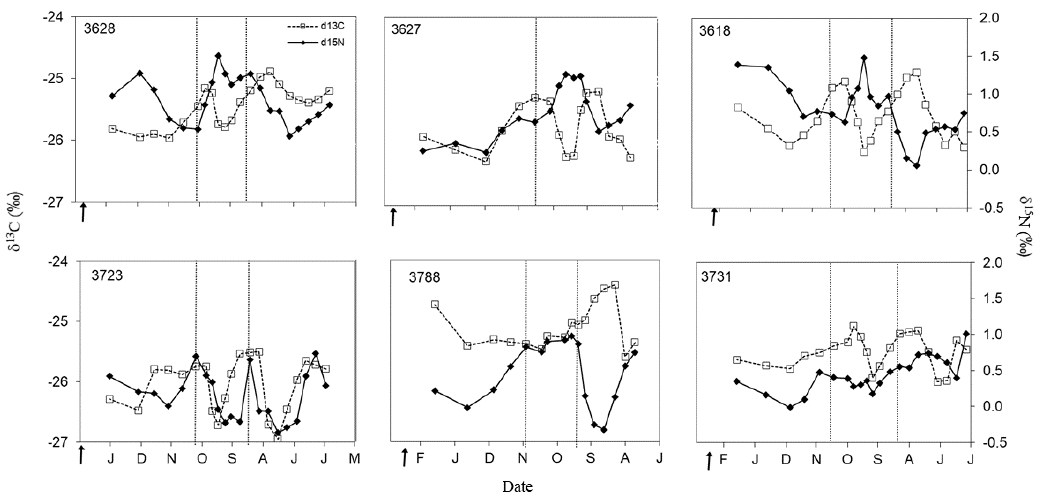
Figure 6. δ 13 C and δ 15 N isotope chronologies along hooves (from hairline to tip) of six adult female moose from the eastern end of Isle Royale National Park, USA. Chronologies are based upon growth rate of captive caribou (Barnett 1994) scaled to moose hoof length. Vertical dotted lines correspond to position of growth arrest lines (GALs) along hooves. Arrows indicate date of death for each individual.